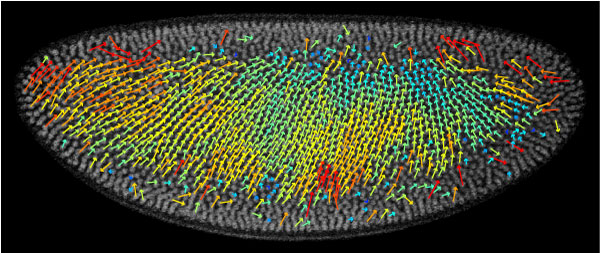
The distance and direction of nuclear movement in an individual living Histone2A-GFP embryo. Nuclei were tracked throughout stage 5, and the vector of their total motion was plotted on top of the image of the embryo at the beginning of stage 5. The color of the arrows is given by their length, short arrows being blue and long ones red. Vectors that are very different from nearby vectors were not used when generating the averaged plots in Figure 2. Anterior is to the left and dorsal is up.